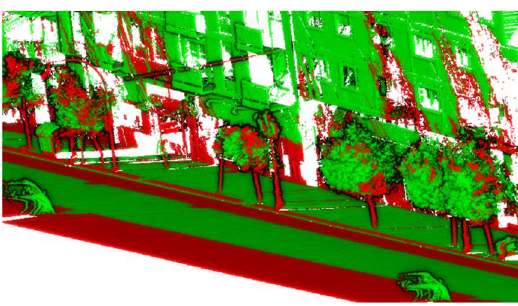
Figure 11: Point cloud coloured by correct semantic segmentation for 11 classes, 200 hidden layers and weighted. Correct segmented classified point in green and misclassified in red.